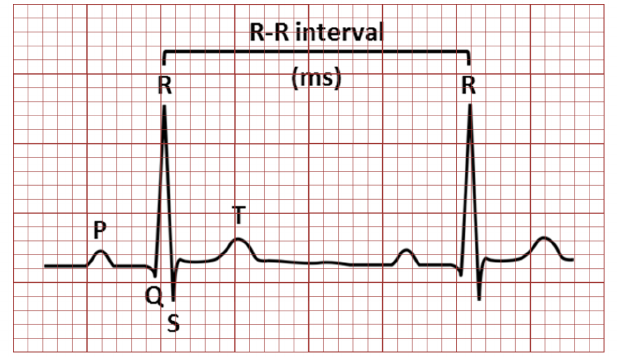
Figure 2. ECG tracing in healthy